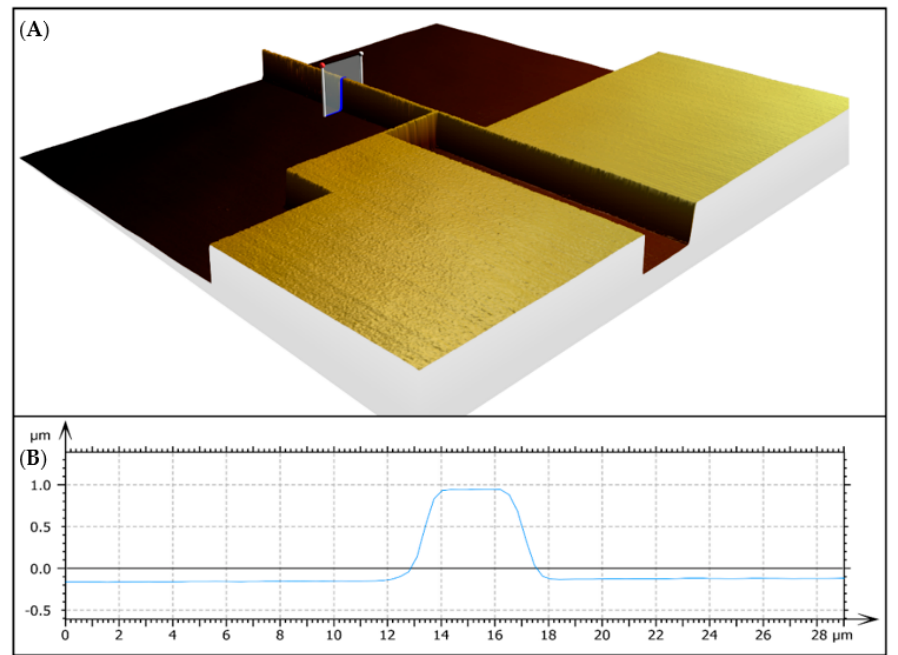
Figure 2. Z-scan performed with LSM: ( A ) 3D image created from z-scan showing the contact pads and the heater line itself. ( B ) Cross-section of the heater along the marker in ( A ).